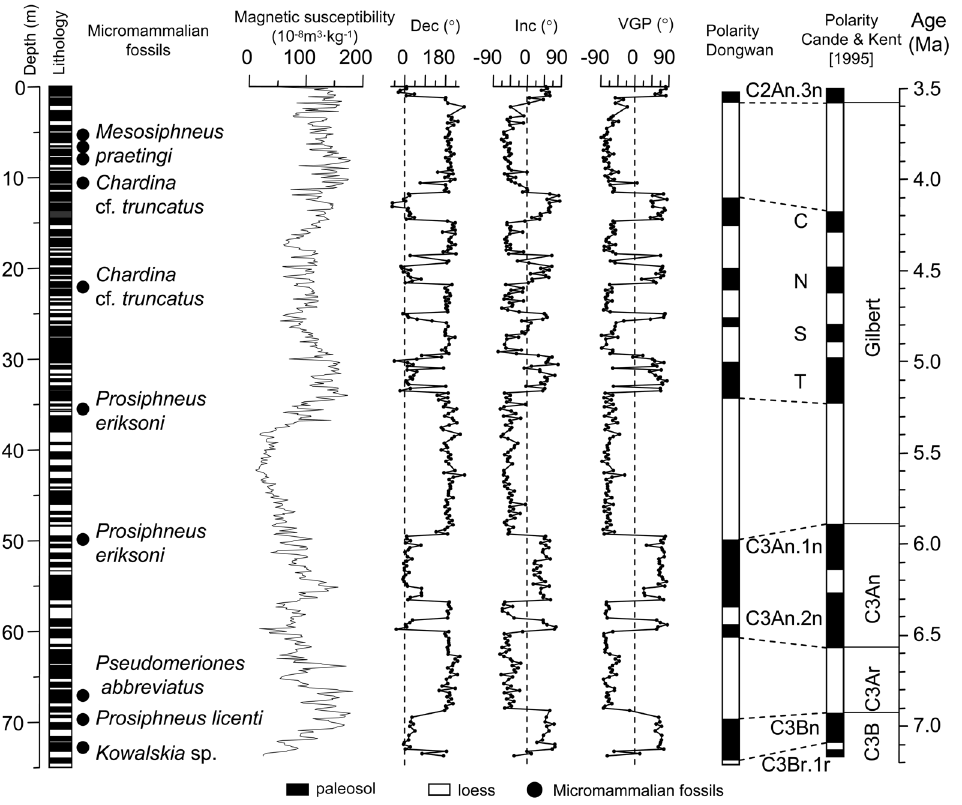
Figure 2. Chronology of the Dongwan loess-paleosol sequence (modified after Hao and Guo, 2004) [41].